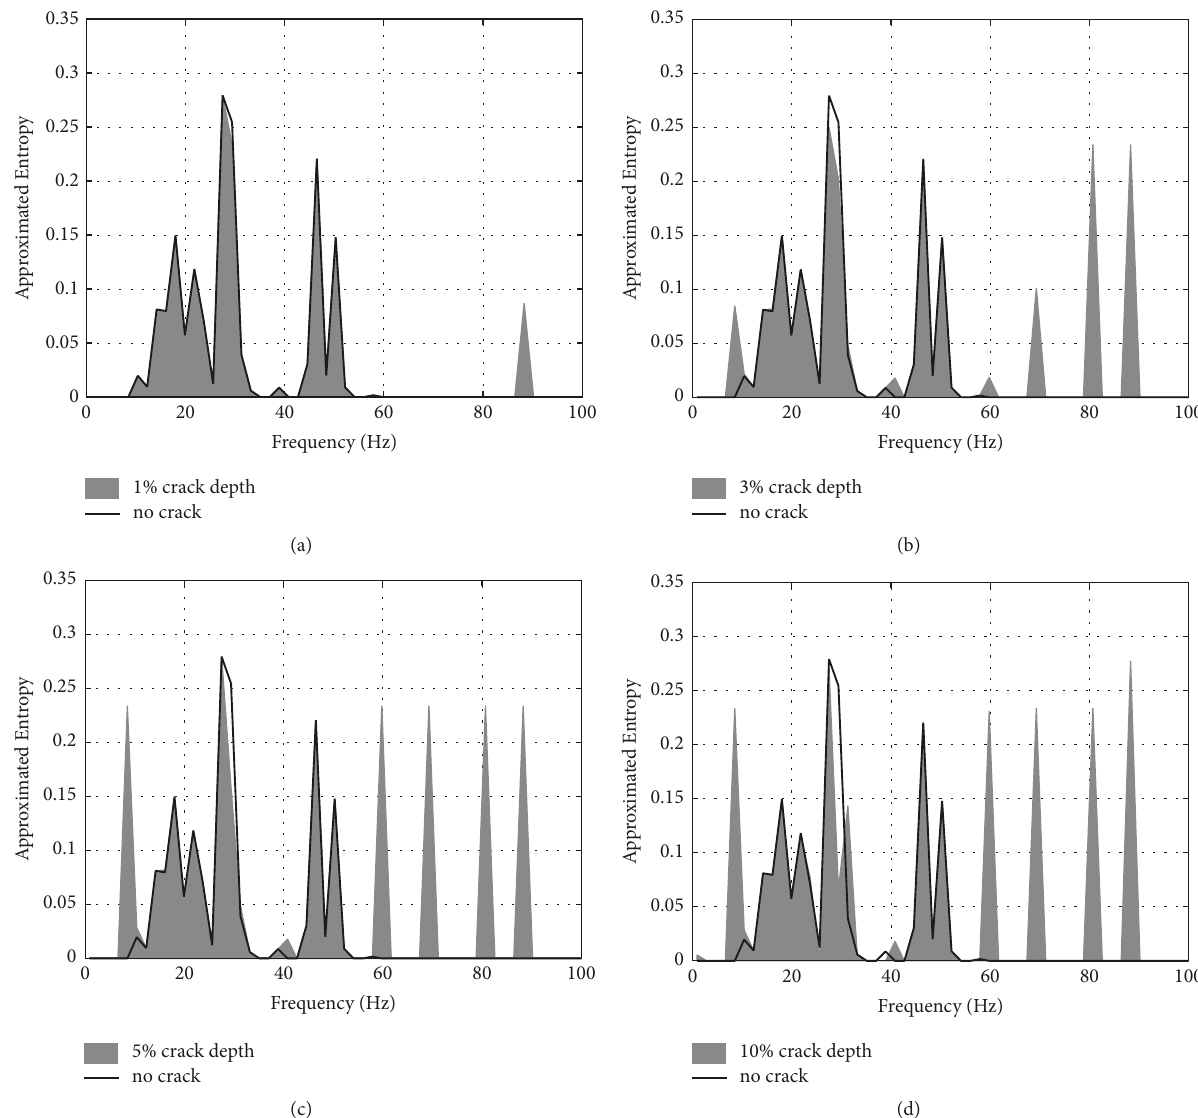
Figure 10: Approximated Entropy of the FFTs of the rotating system (SNR = 1000, 𝑟 = 5 × 10 −5 ). Comparison between the cases of healthy shaft and cracked shaft: (a) 1% crack depth; (b) 3% crack depth; (c) 5% crack depth; (d) 10% crack depth.